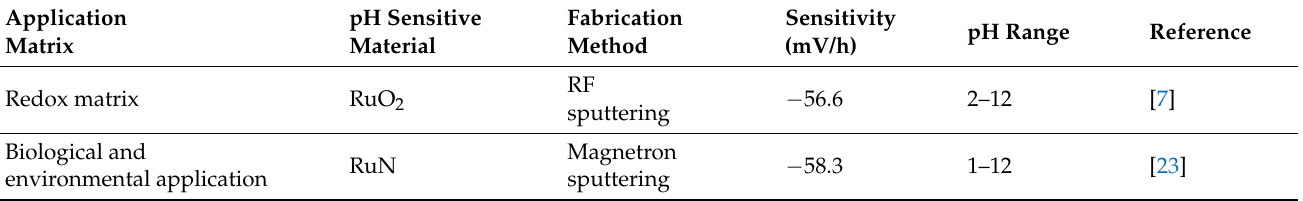
Table 1. Comparison of current work on metal nitride-based pH sensors applied in redox matrix to previous work from the literature. * No conditioning protocol required for this sensor as compared to the RuO 2